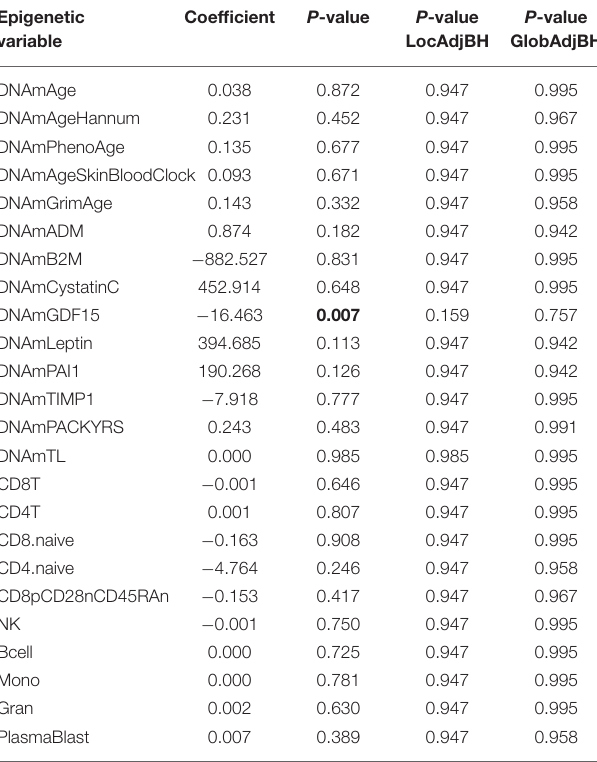
TABLE 3 | Results of association analysis between epigenetic measurements and HPST values in the HPS cohort, correcting for chronological age, and including family as a random effect.